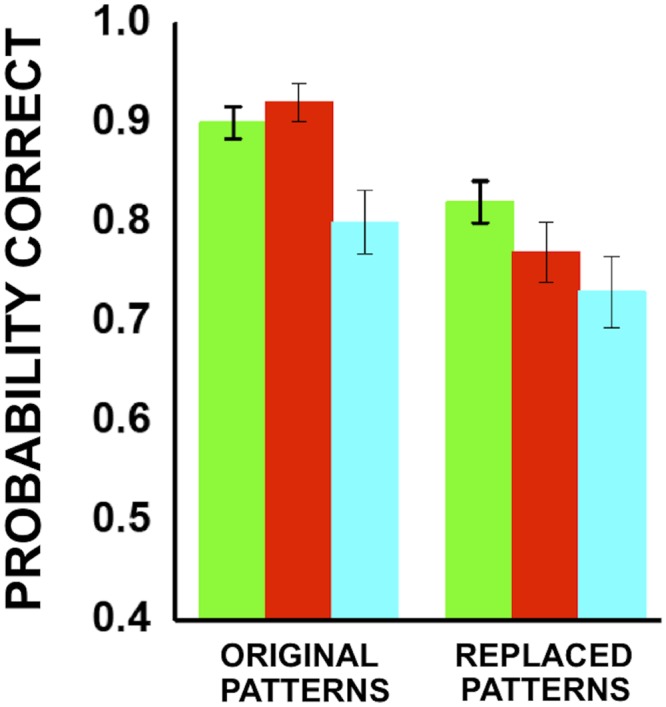
Effect of local features.Discrimination of sketches obtained with optimal patterns (left) and of sketches where optimal patterns were replaced by randomly chosen non-optimal patterns (right). Each color represents a different subject.